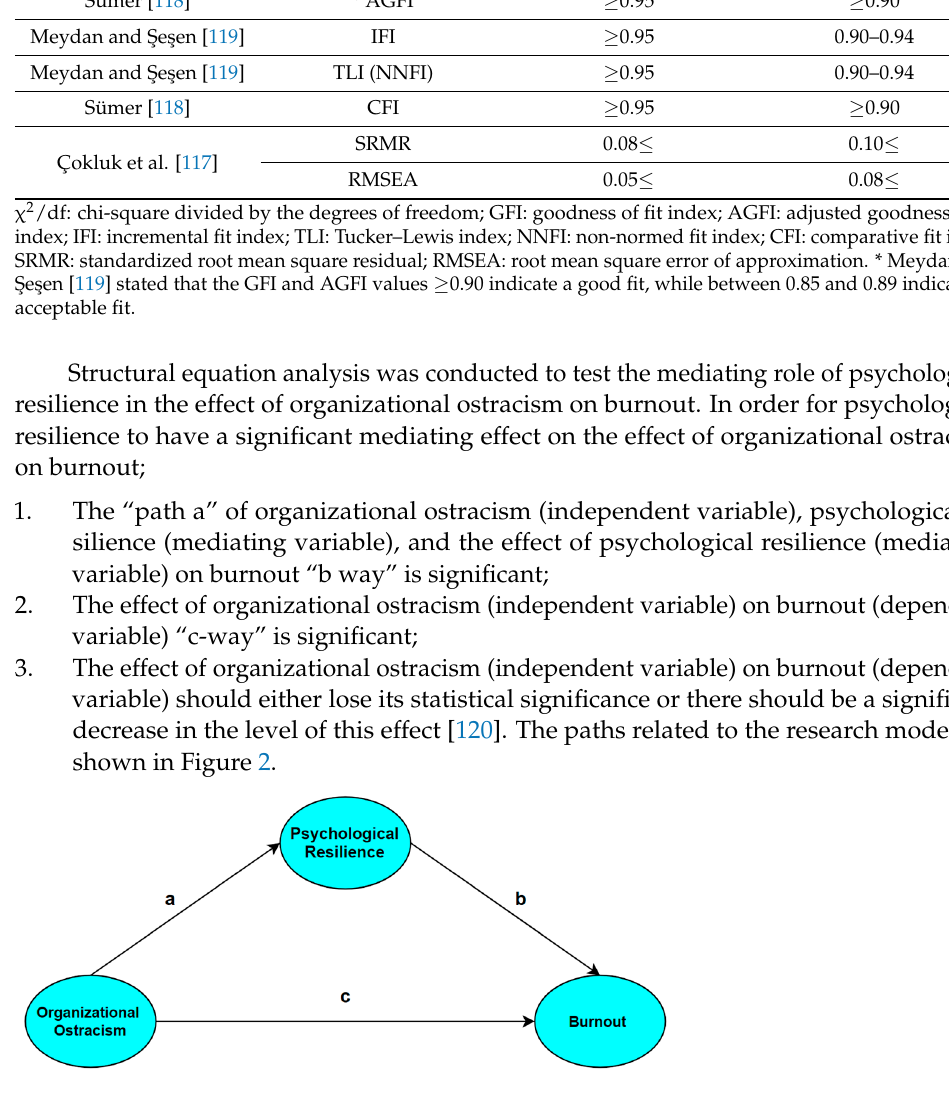
Figure 2. The pathways for research model .